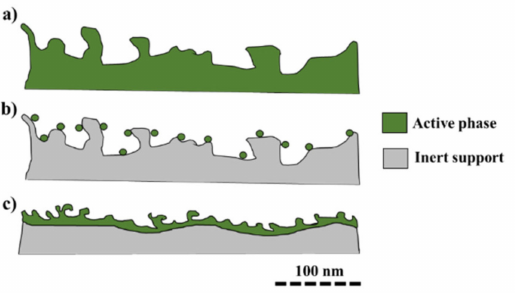
Figure 1. Types of monoliths as a function of the method of deposition of the active phase and of the porous properties of the monolith constitutive material. ( a ) integral ( b ) high-surface ( c ) low-surface. Integral monoliths (Figure 1a) are partially or entirely made out of the active